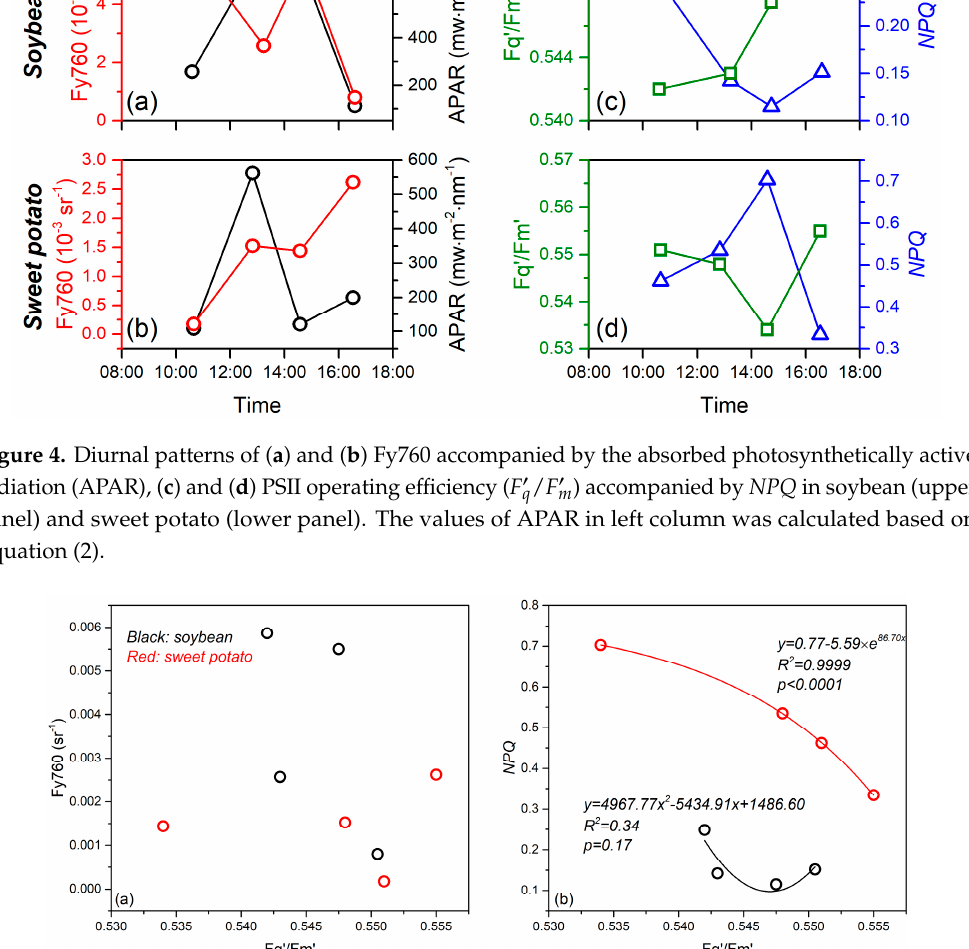
Figure 5. Relationship of the PSII operating e ffi ciency ( F (cid:48) q / F (cid:48) m ) with ( a ) the solar-induced chlorophyll fluorescence (SIF) yield (Fy760) and ( b ) non-photochemical quenching ( F m / F (cid:48) m − 1, NPQ ) based on the diurnal measurements of soybean (black) and sweet potato (red).